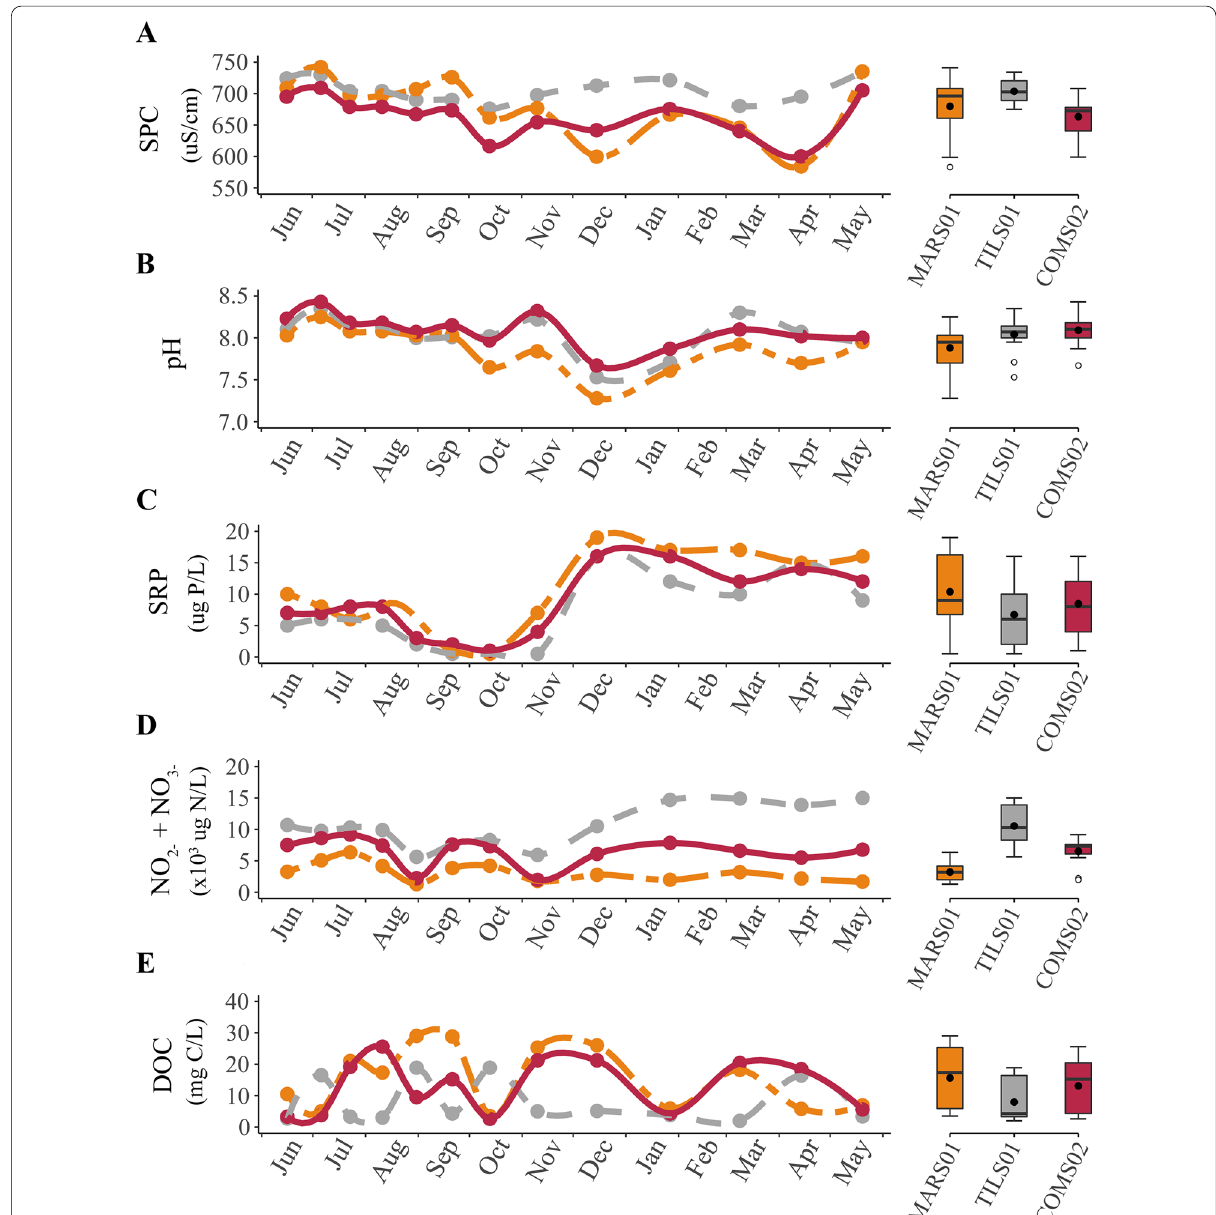
Fig. 2 Time series of specific conductivity (SPC) ( A ), pH ( B ), soluble reactive phosphorus (SRP) ( C ), nitrate-nitrite ( D ), and dissolved organic carbon (DOC) ( E ) with boxplots (25th, 50th, and 75th percentiles; whiskers denote sourced by a marsh (two dash, orange) and tile drain (dash, grey), as well as the downstream combined segment (solid, magenta) over 13